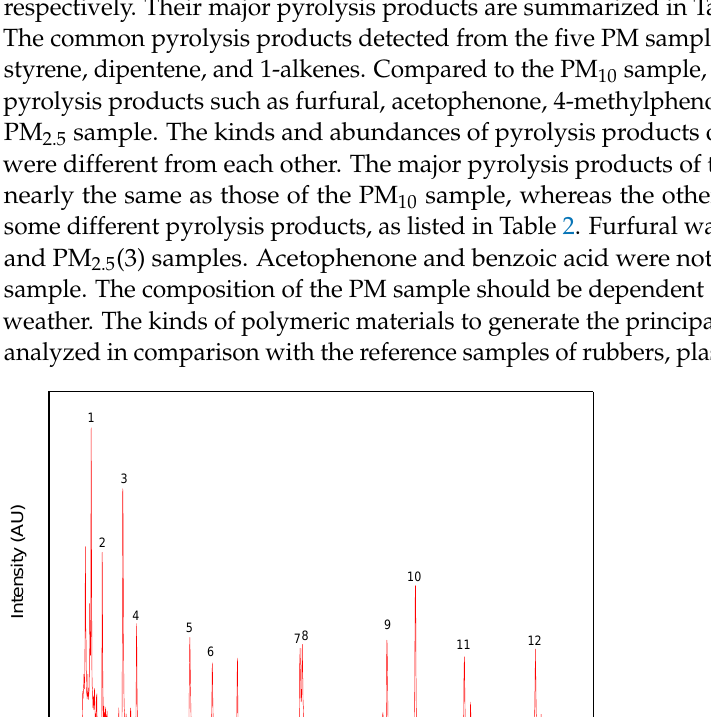
15 12 Figure 2. Py-GC/MS chromatograms of the PM 2.5 (1), PM 2.5 (2), PM 2.5 (3), and PM 2.5 (4) samples. Table 1. Peak areas and relative intensity ratios (the reference: 1-undecene) of the major pyrolysis products detected in the PM 10 sample. Peak No.